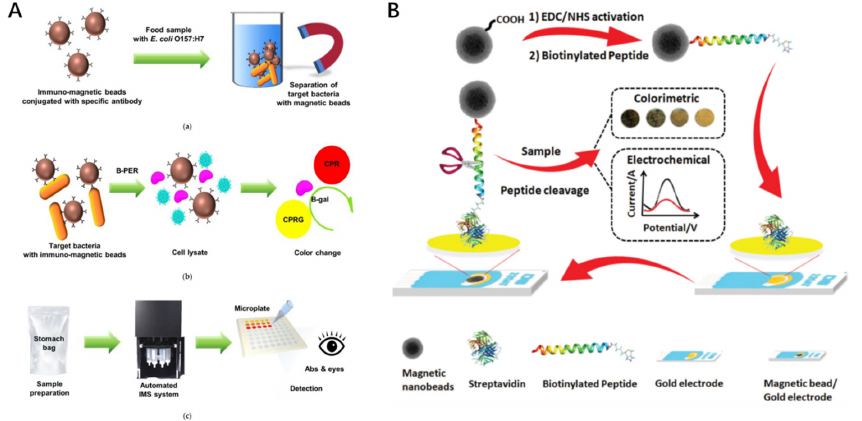
Figure 1. Schematic illustration of experimental procedures: ( A ) detection of Escherichia coli (E. coli) O157:H7 using auto- mated immunomagnetic separation and enzyme-based colorimetric assay (reproduced with permission from [42]; pub- lished by MDPI, 2020); ( B ) a dual electrochemical/colorimetric MNP/peptide-based platform for the detection of S. aureus (reproduced with permission from [44]; published by the Royal Society of Chemistry, 2020).